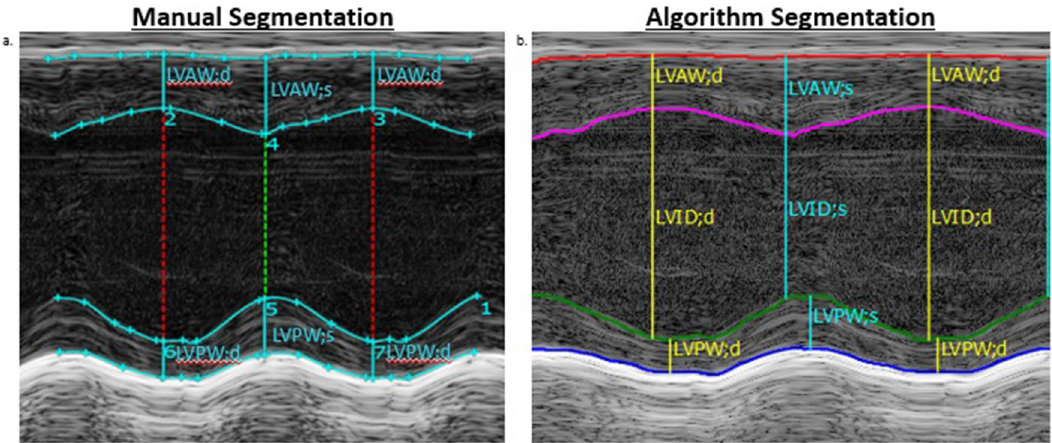
Figure 5. M-mode ROI’s: 2-dimensional short axis images of the left ventricle of C57BL/6 mice. Visual comparison of manually segmented ROI (left) vs. ROI generated from the semi-automated segmentation algorithm of the same images (right). ( a ) Shows a representative baseline LV M-mode echocardiogram from a mouse that was traced manually. ( b ) Shows the same baseline LV M-mode echocardiogram segmented using the semi-automated algorithm for analysis.